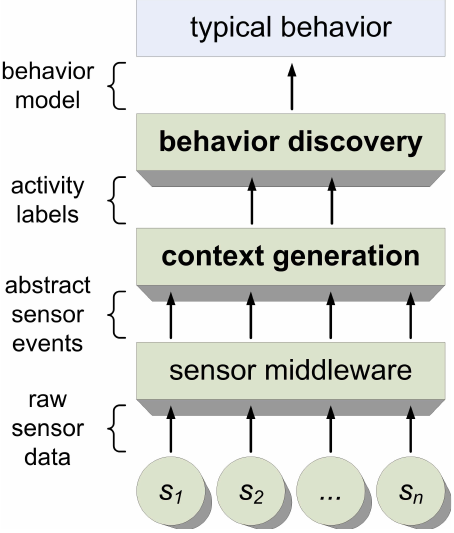
Figure 1. System overview with two main building blocks: context generation module and behavior discovery